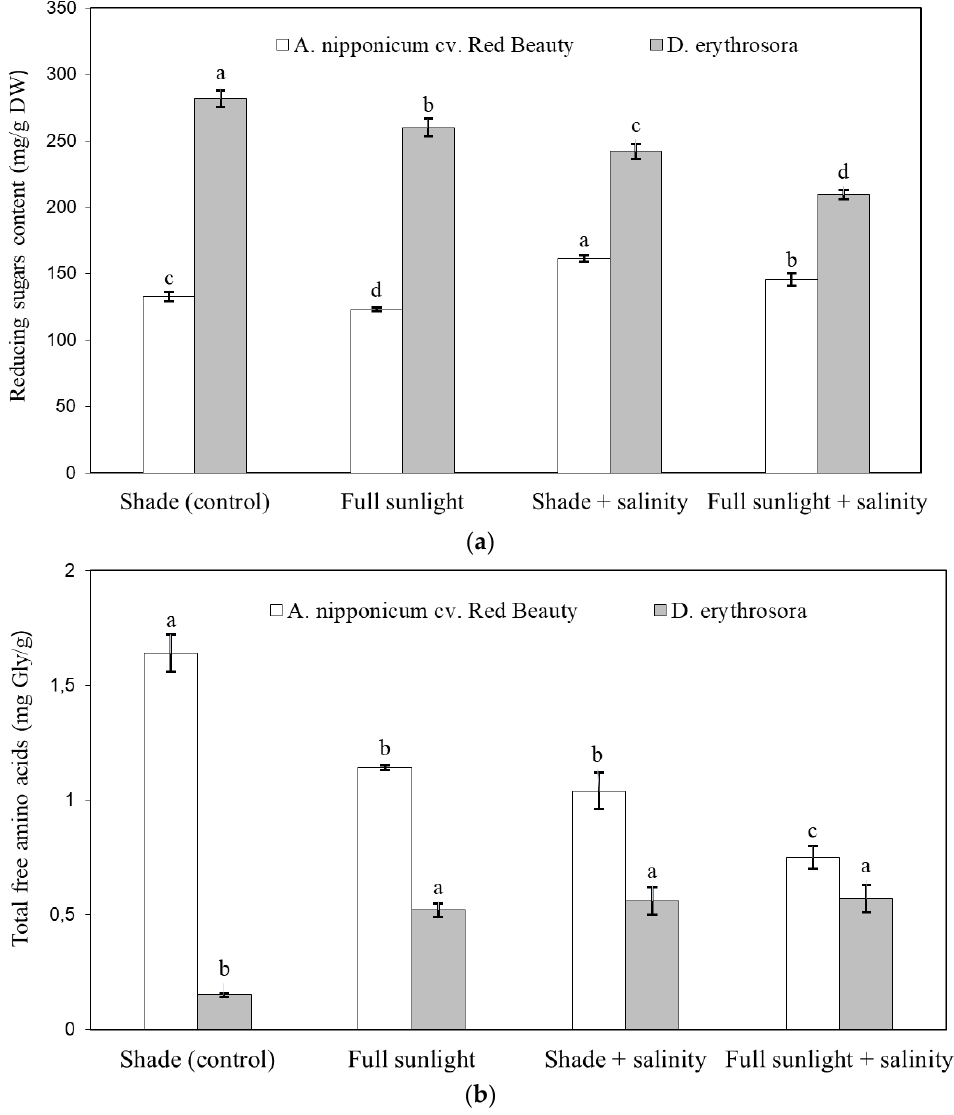
Figure 1. Effect of abiotic stresses on reducing sugars ( a ) and total free amino acid content ( b ) of two hardy ferns. Vertical error bars indicate the standard deviation of the mean. Different letters indicate a significant difference between treatments within given taxa at the p ≤ 0.05 (ANOVA, Tukey’s HSD post hoc test).